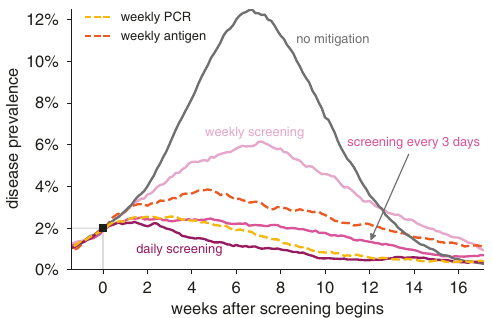
Fig. 5 Impact of olfactory dysfunction screening on an ongoing viral outbreak. Examples of the impact of screening programs based on olfactory dysfunction on controlling an ongoing outbreak. Viral spread in a fully- mixed community of 20,000 individuals was allowed to proceed until prevalence reached 2%, at which point olfactory dysfunction (OD) screening was initiated either daily (dark red), every 3 days (red), or weekly (pink). For comparison, weekly RT-PCR testing with a 1 day turnaround (dashed yellow line) and weekly antigen testing (dashed red line) are shown. Olfactory dysfunction is modeled to be present in 75% of infected individuals, last 7 days, and begin 2 days after viral levels reach ~1000 virions/ml. Our modeling assumed that 80% of people would opt to participate in testing and that 20% of people would be unable to participate due to COVID-19-independent olfactory dysfunction. Scenario without mitigation is shown for comparison (black).